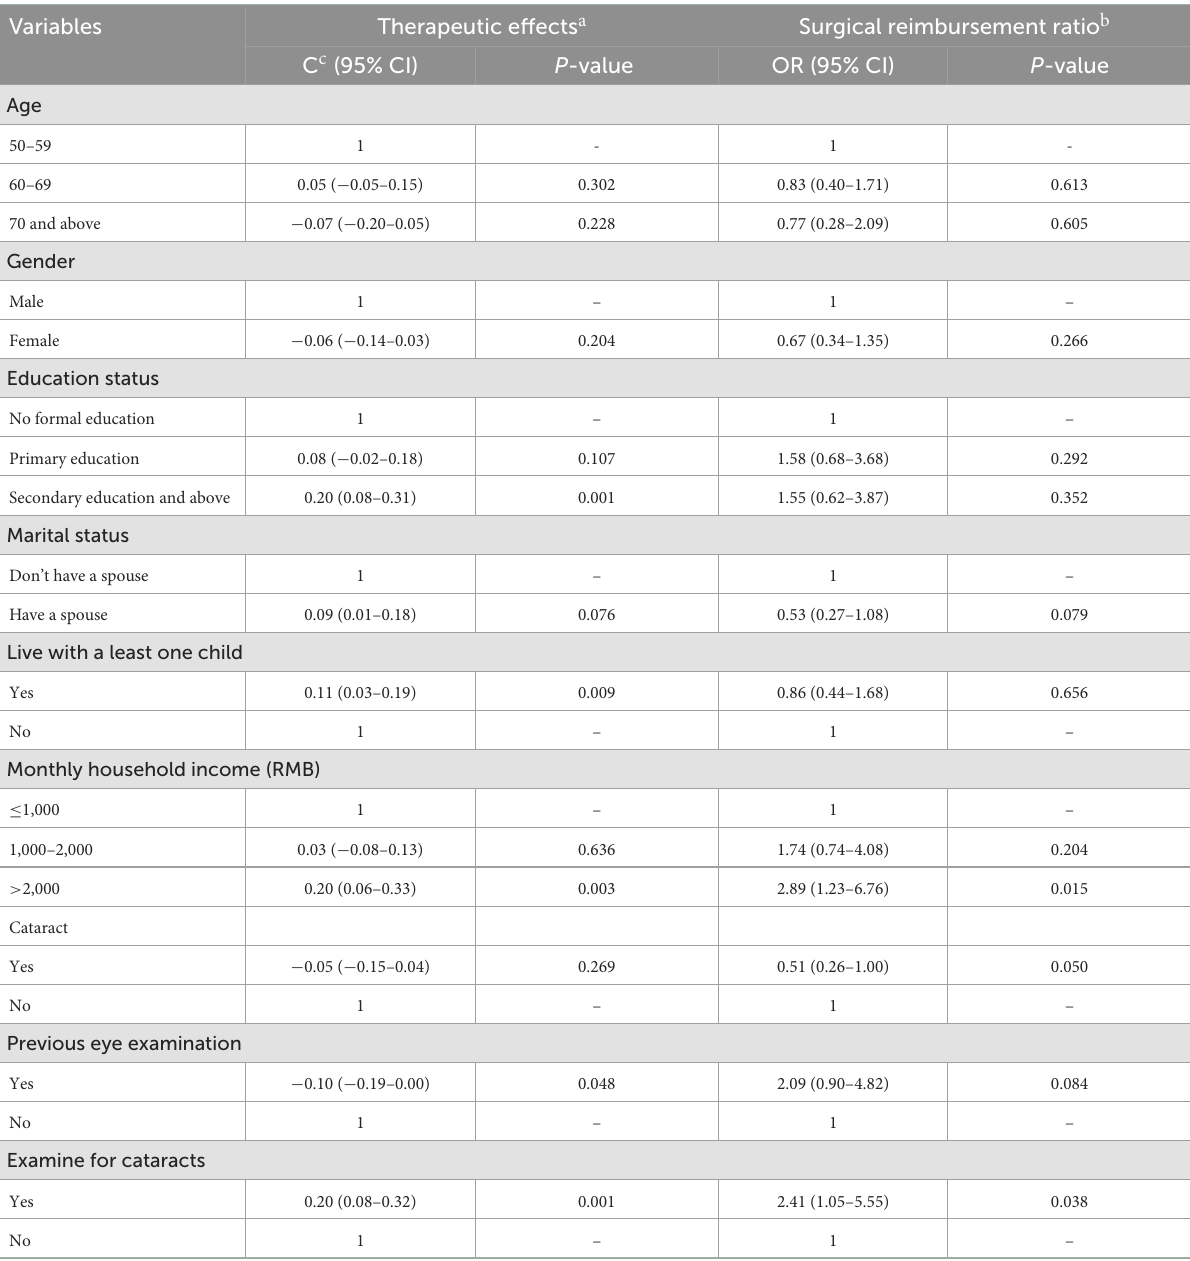
TABLE 5 Factors associated with therapeutic effects, surgical reimbursement ratio for cataracts of adults aged 50 and above in rural western China